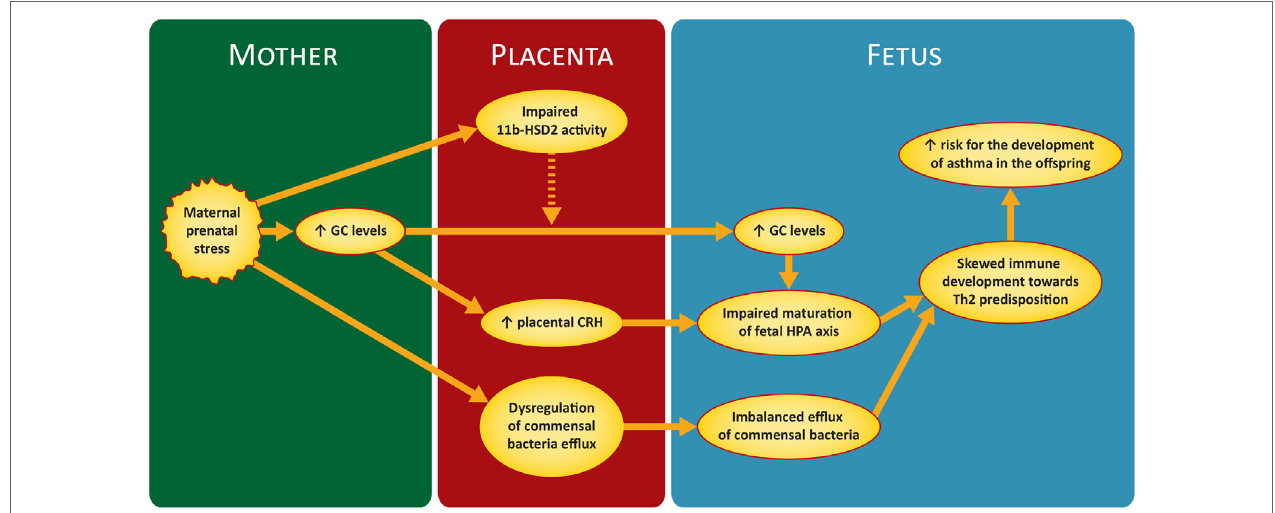
FiGURe 1 | Proposed mechanism of maternal prenatal stress in asthma predisposition in the offspring. GC, glucocorticoids; CRH, corticotrophin releasing hormone; 11 b-HSD2, 11-b hydroxysteroid dehydrogenase-type 2; HPA,